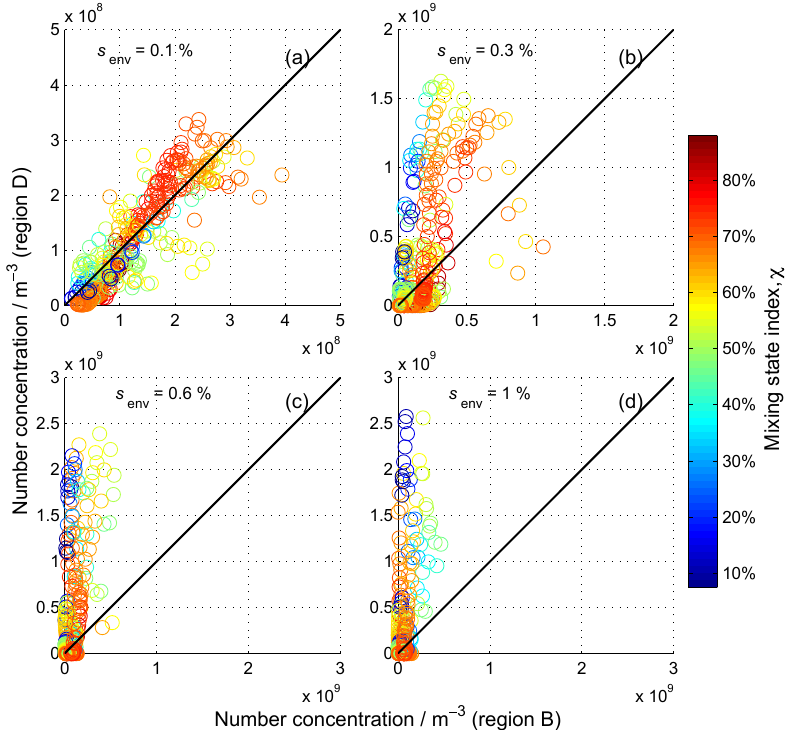
Figure 8. Relationship of number concentration in quadrants B and D (compare Fig. 5) for different environmental supersaturations. The data points are colored corresponding to the mixing state index χ